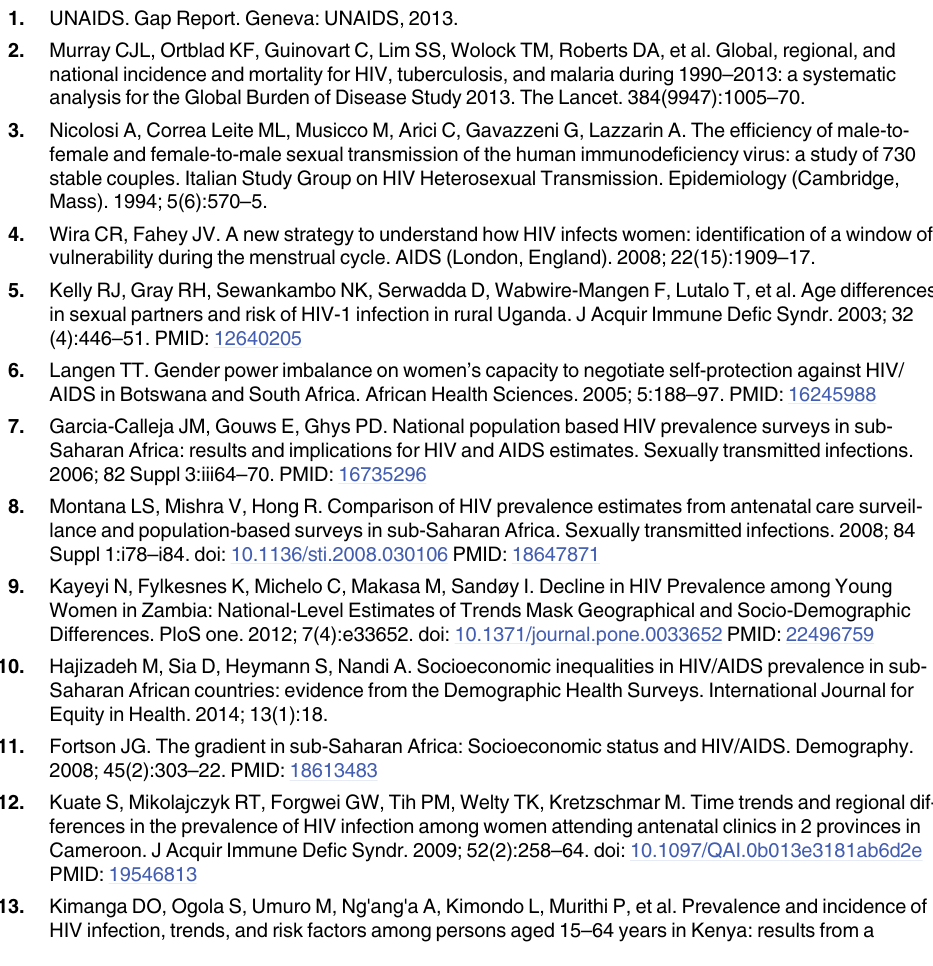
S2 Table. Age-adjusted female: male HIV prevalence ratio by region, urban/rural residence and marital status (15 – 24 years). S3 Table. Age-adjusted female: male HIV prevalence ratio by region, urban/rural residence and educational level (15 – 24 years). S4 Table. Educational categories.